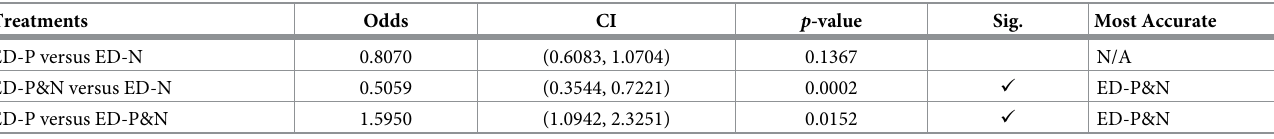
Table 5. ED : Set cardinality accuracy analysis.